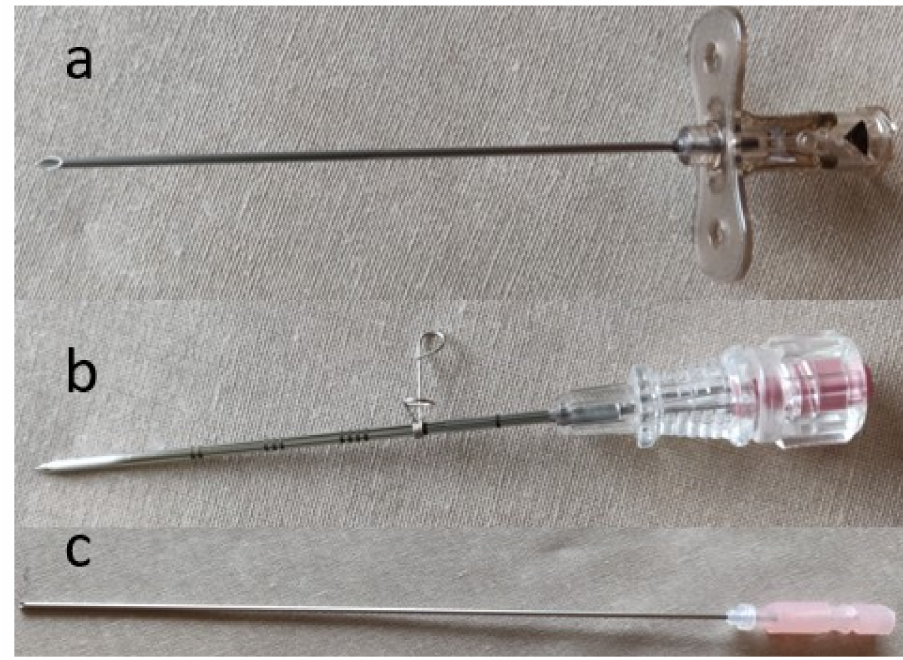
Figure 1. Photograph shows basic needles. (a) Single-wall, hollow-core needle, (b) Trocar needle, and (c) Chiba